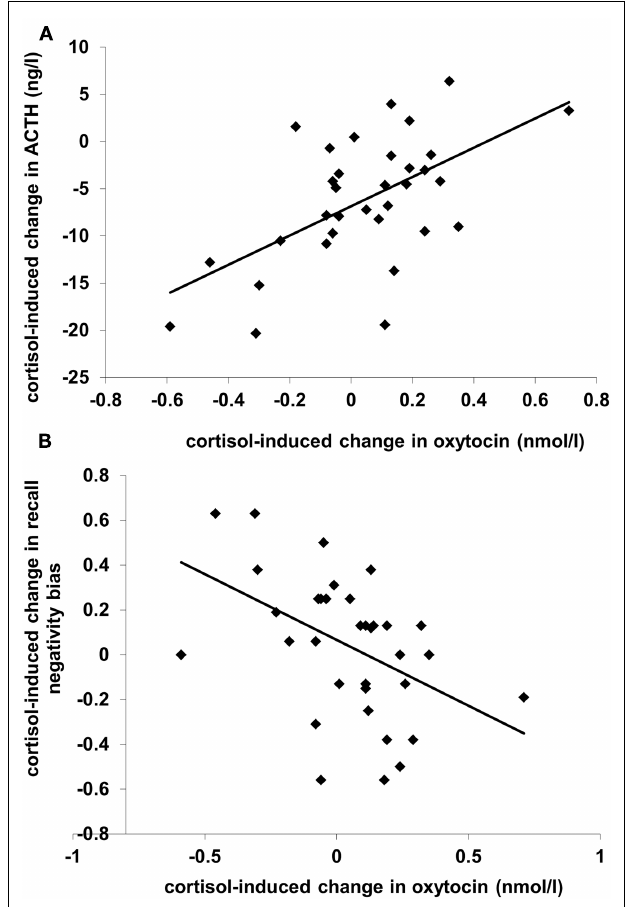
FIGURE 1 | Scatterplots of (A) cortisol administration-induced change in plasmaACTH level ( N = 33) and (B) cortisol-induced change in recall negativity bias ( N = 35), both (in (A) and (B)) as a function of cortisol-induced change in plasma oxytocin level. Levels from the placebo condition are subtracted from levels from the cortisol condition; positive values reflect increases.The recall negativity bias is the proportion unpleasant words recalled minus the proportion pleasant words